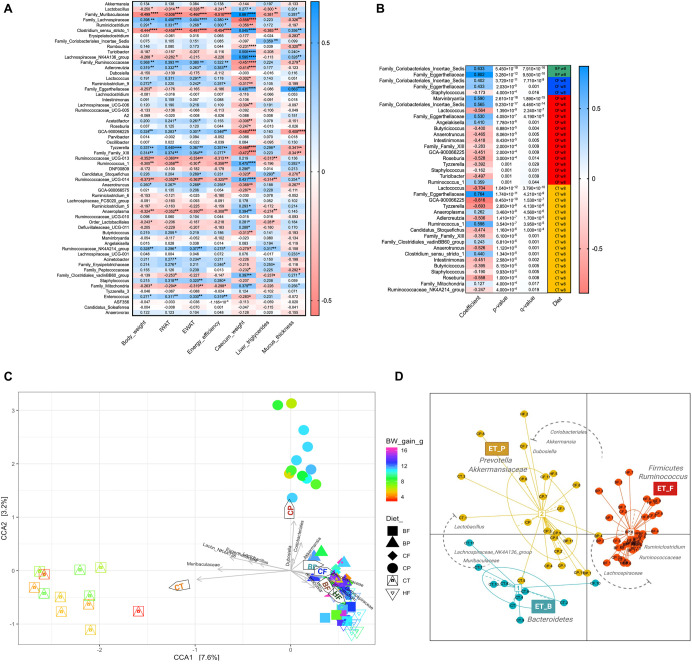
Widespread prebiotic role of polyphenols and fibers on bacterial taxa and their correlations with mice phenotypes and microbiota enterotype-like clustering. (A) Heatmap showing microbial associations (spearman R2 scores) with mice obesity phenotypes. Each row represents the effects of one of the 59 ASVs (>0.05% relative abundance) in each of the mouse phenotypes in columns. Asterisks indicate taxa for which the association was significant, *p < 0.05, **p < 0.01, ***p < 0.001, and ****p < 0.0001. (B) Taxa showing opposing or compatible connection with the type of diet supplementation based on MaAslin model applied for uncovering the prebiotic effects of berry constituents. Rows represent different taxa exhibiting main interaction with each of the type of diet supplementation. Columns represent coefficient scores, p-value (p < 0.05), FDR corrected p-value (q < 0.05) and diet interaction. Taxa showing compatible correlation are indicated in blue color and those negatively correlated are indicated in red color. (C) Ordination of Canonical Correspondence Analysis (CCA) showing the connection between samples and environmental variables along with representative taxa significantly modulated by the diets in mice gut microbiota. Mice were fed a HFHS-diet (HF), Chow (CT), polyphenol-rich whole cranberry powder (CP), cranberry fiber-rich fraction (CF), polyphenol-rich whole blueberry powder (BP) and blueberry fiber-rich fraction (BF). Arrows indicate environmental variables and taxa discriminating the dietary groups: Mucus_thickness, IWAT, Liver_TG, Energy_efficiency, Lactobacillus, Muribaculaceae, Lachnospiraceae, Lachnospiraceae_NK4A136, Eggerthellaceae, Coriobacteriales, Dubosiella, and Akkermansia. Symbol colors of each group represents changes in mouse body weight gain (BW). (D) Ordination on Jensen-Shannon metrics shows enterotype-like clustering of mice gut microbiota (colored ellipses); dots represent abundance distributions of bacteria genera from each mouse. Three enterotypes were identified: (1) ET_B, Bacteroidetes/Muribaculaceae; (2) ET_P, Prevotella/Akkermansiaceae; and (3) ET_F, Firmicutes/Ruminococcus. Taxonomic drivers of enterotypes are indicated in the plot (see Supplementary Figure S4).